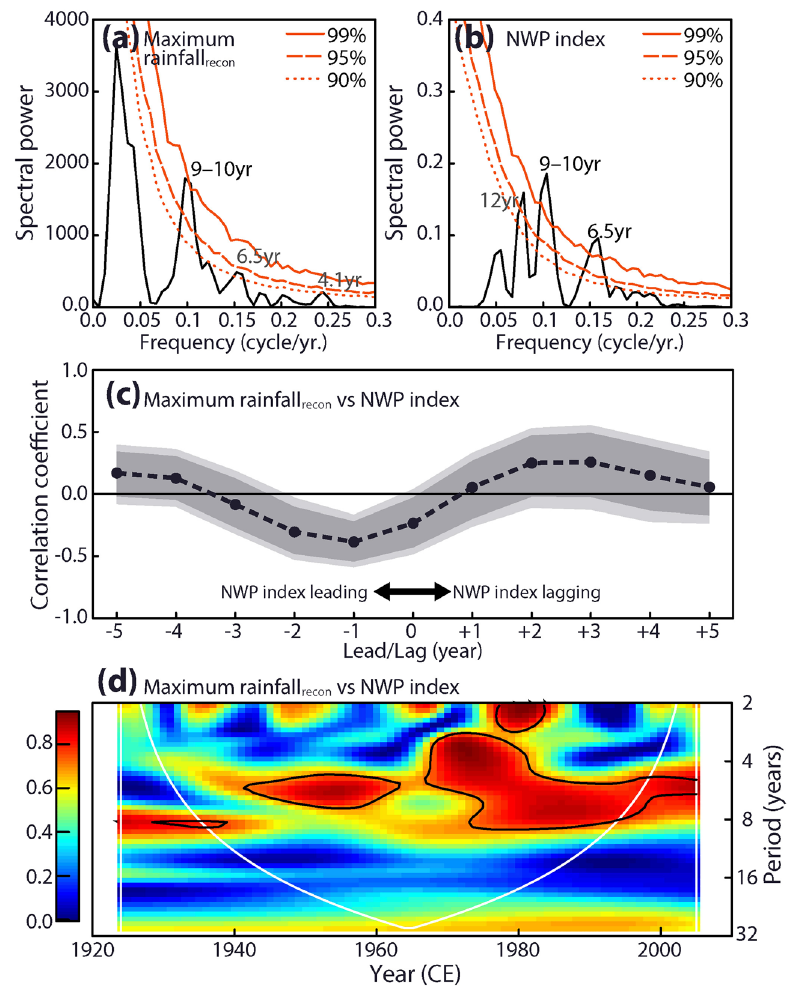
Figure 3. Relationship between the maximum rainfall recon and the CP ENSO. ( a , b ) REDFIT spectral analyses 39 for the maximum rainfall recon and the NWP index. Red lines indicate bootstrap confidence intervals for the spectral power (solid: 99%; dash: 95%; dot: 90%). The REDFIT spectral analyses were performed using PAST software version 4.04 47 . ( c ) A lead-lag correlation analysis between the NWP index and the maximum rainfall recon . Shading areas indicate the confidence bands of correlation coefficients (light colour: 99%; thick colour: 95%). ( d ) A wavelet coherency between the maximum rainfall recon and the NWP index. The solid black lines indicate a 95% confidence level. White lines show the cone of influence, where edge effects reduce the